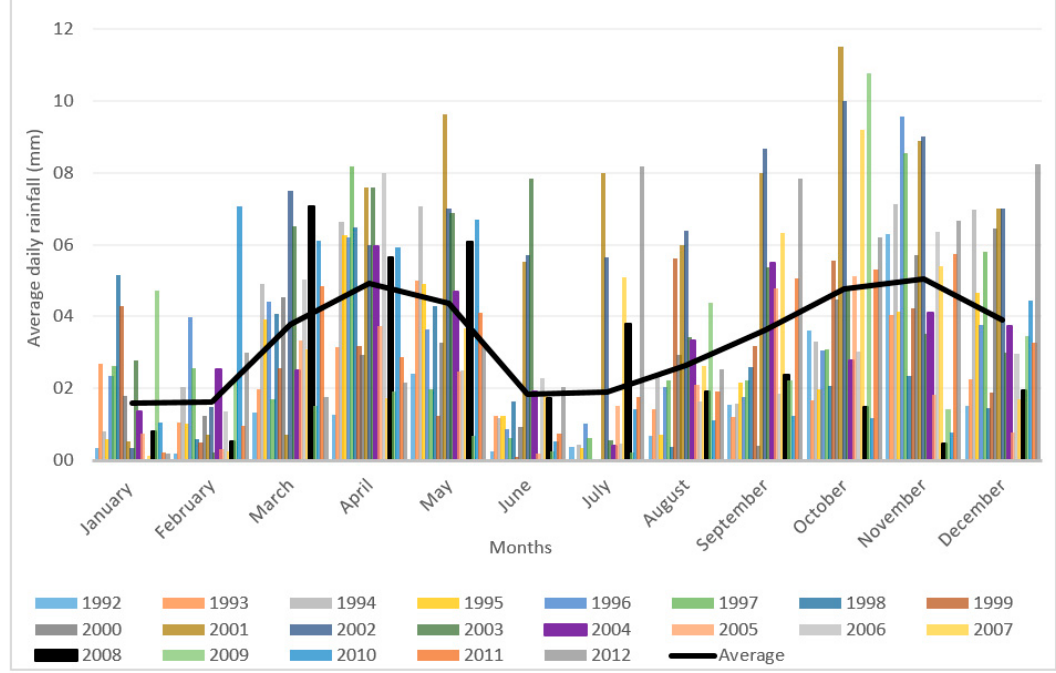
Figure 2. Daily observed rainfall for Kyembogo station (1992–2012).